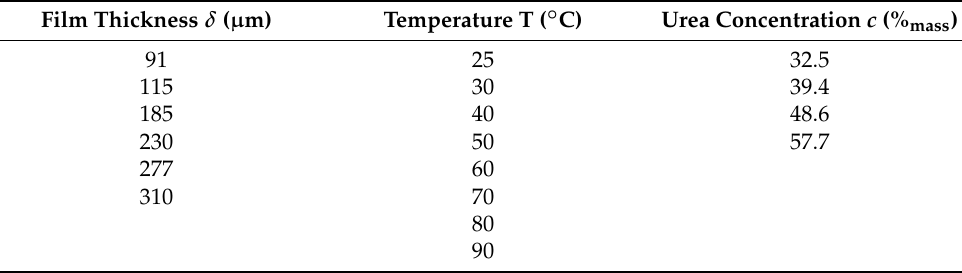
Table 1. Parameter variations for calibration data